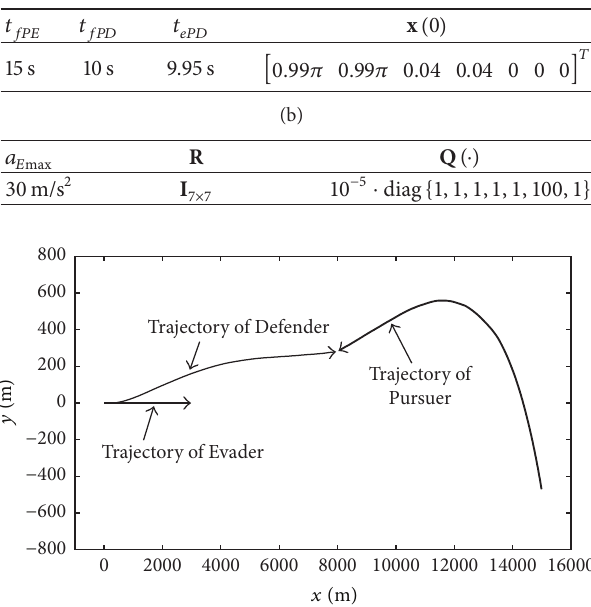
Figure 5: The trajectories of the noncooperative case.